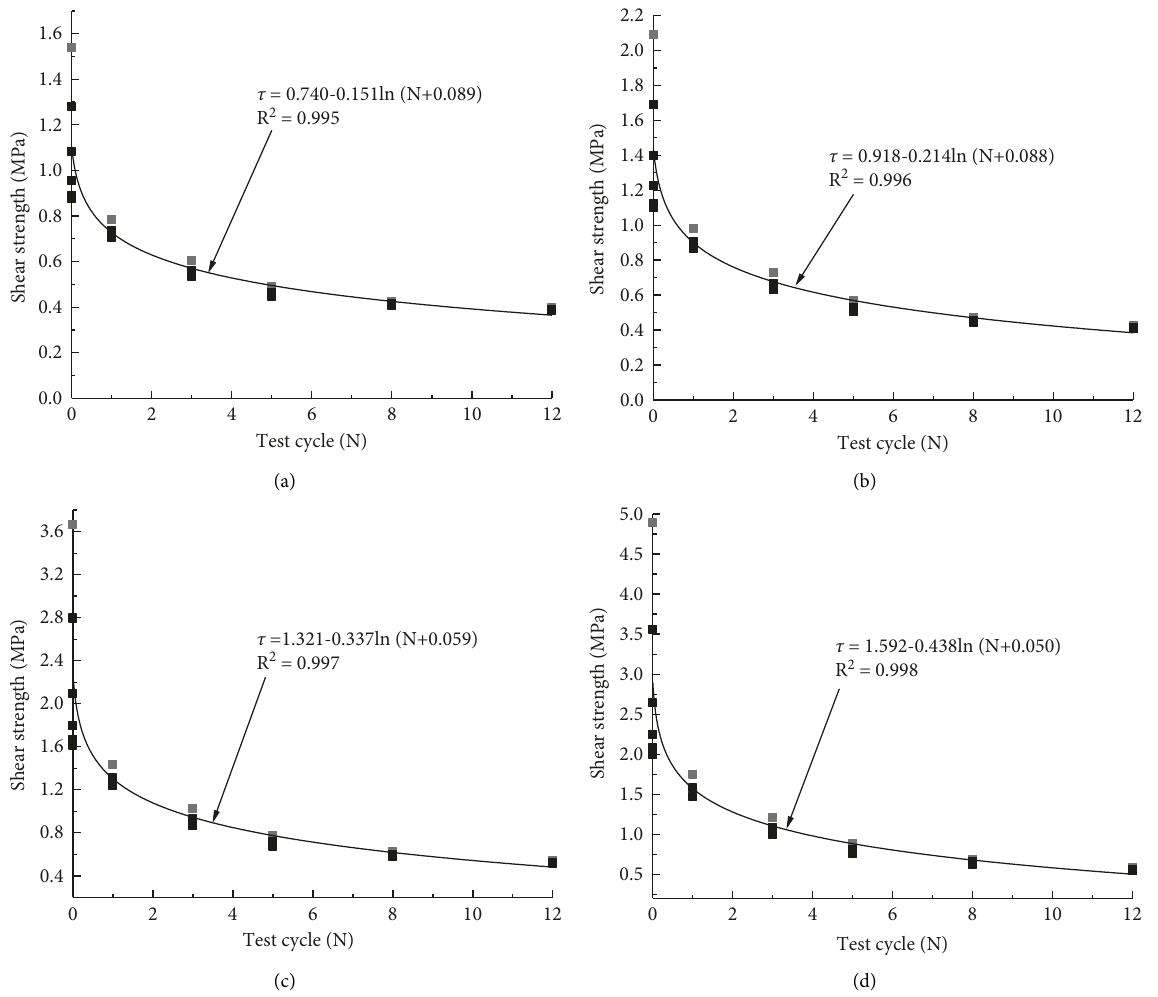
Figure 6: Variation of joint surface’s shear strength under different normal stresses. (a) 0.5 MPa. (b) 1.0MPa. (c) 1.5MPa. (d) 2.0MPa.